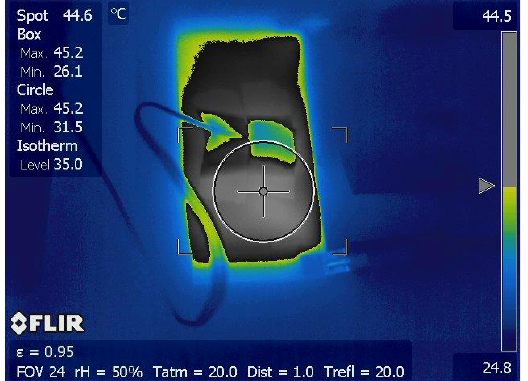
Figure 18. Thermal imaging image of a plate made of thermoplastic composite during heating (Ts not reached). The coil on the surface of the plate is a cable of a thermocouple attached to the sample.